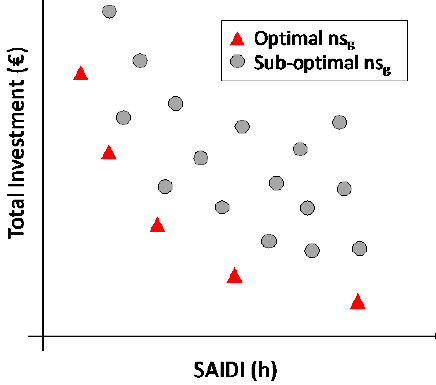
Figure 6. Pareto optimization for NS.